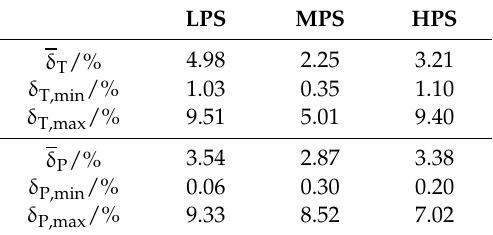
Table 9. Average, minimal and maximal relative errors of steam temperature and pressure. LPS MPS